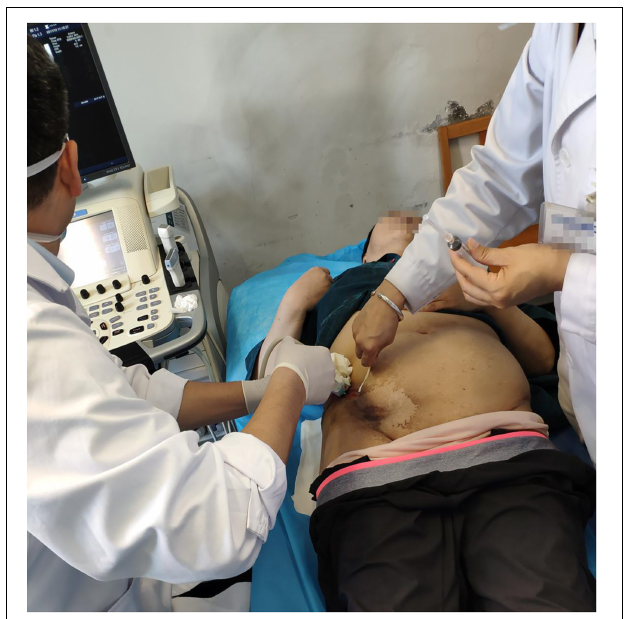
FIGURE 3 | Picture of the local injection